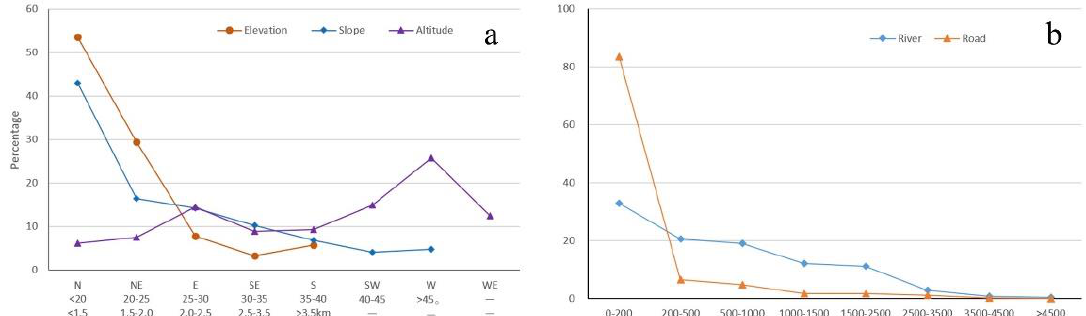
Figure 12. Factors influencing landslide: ( a ) the topographical factors; ( b ) rivers and roads. In panel a, the 1st, 2nd, and 3rd rows of the caption below the lateral axis indicate the category of altitude, slope, and elevation, respectively.